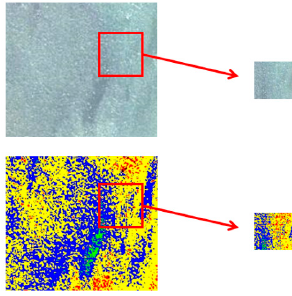
Figure 4. Sample of characteristics’ distribution.